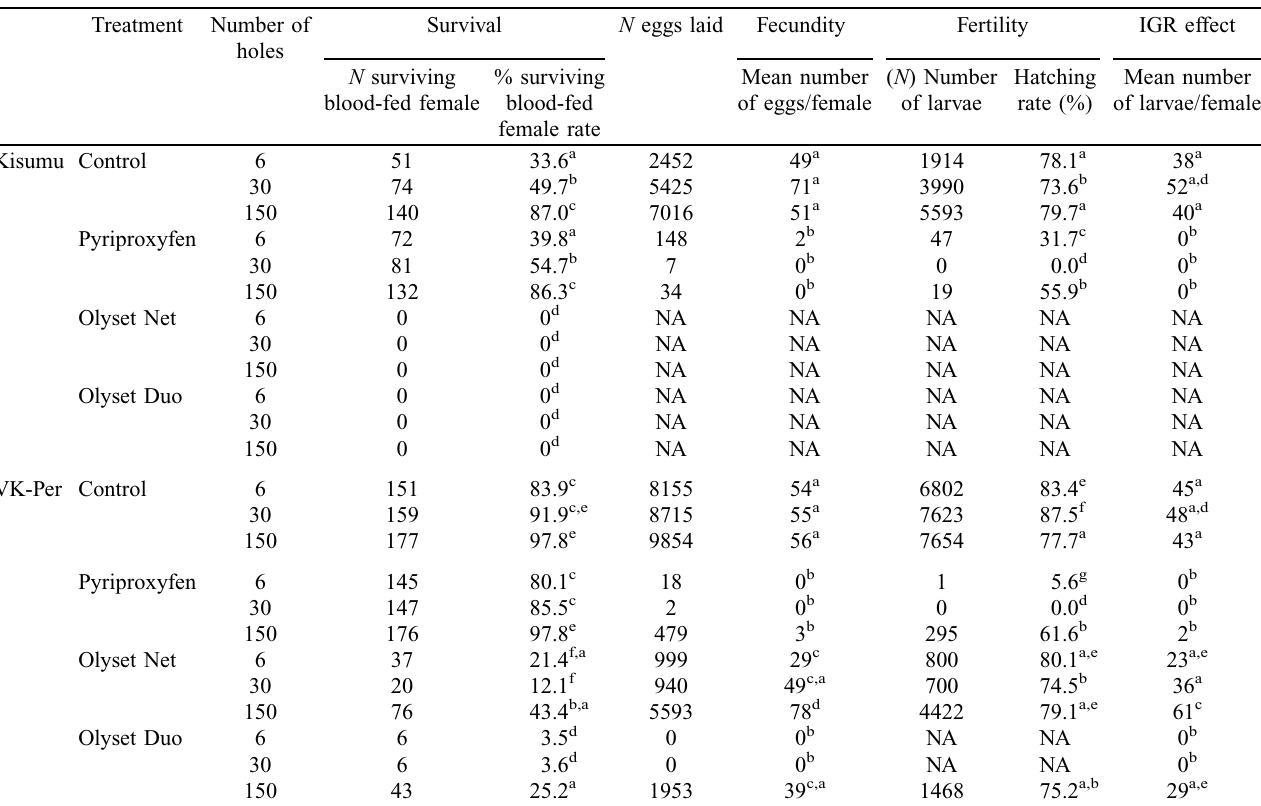
Table 2. Summary results of fecundity and fertility among Kisumu and VK-Per mosquitoes exposed to the various treatments. Treatment Number